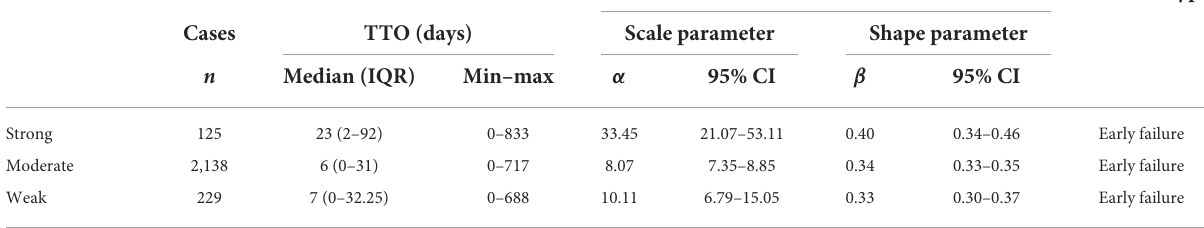
TABLE 4 Time-to-onset analysis for signals with strong/moderate/weak